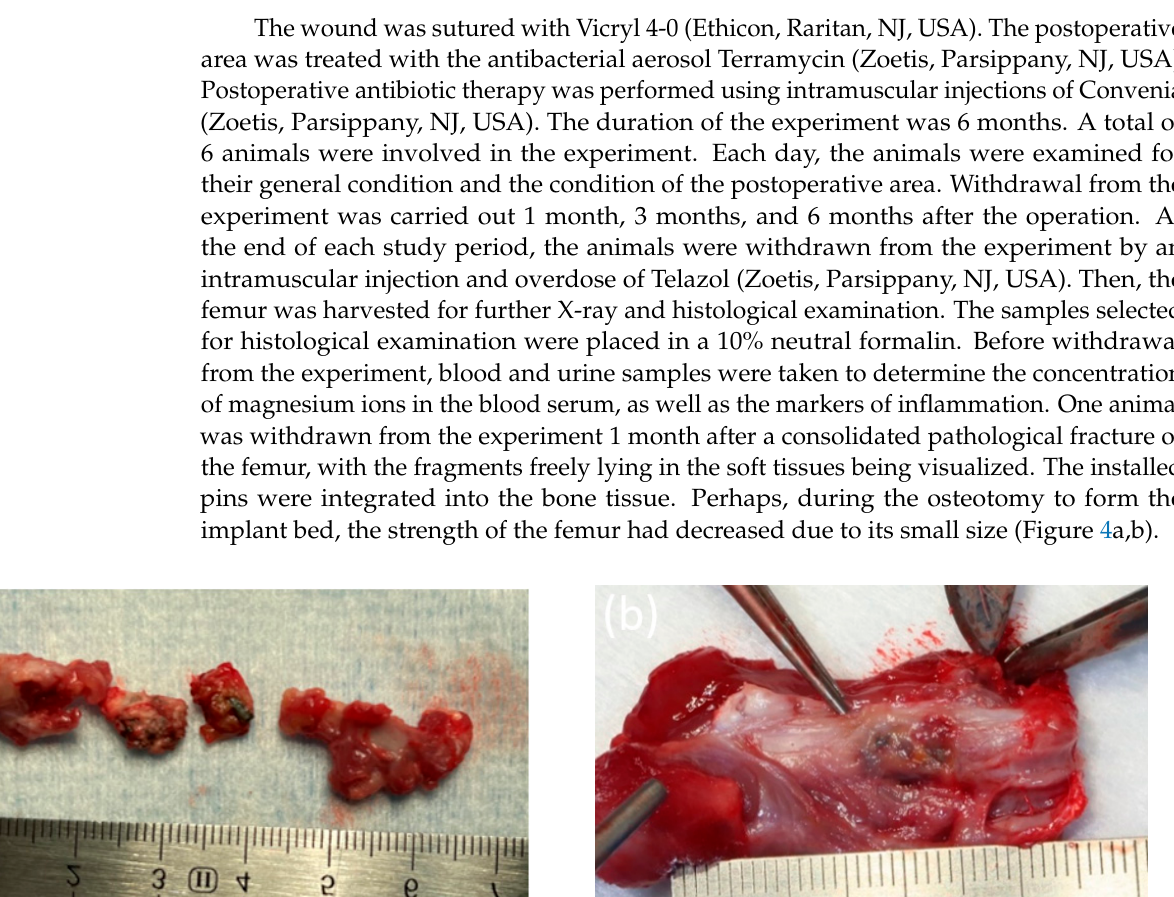
Figure 3. ( a ) The femur of an animal with holes for the implants. ( b ) The appearance of the operating areas after